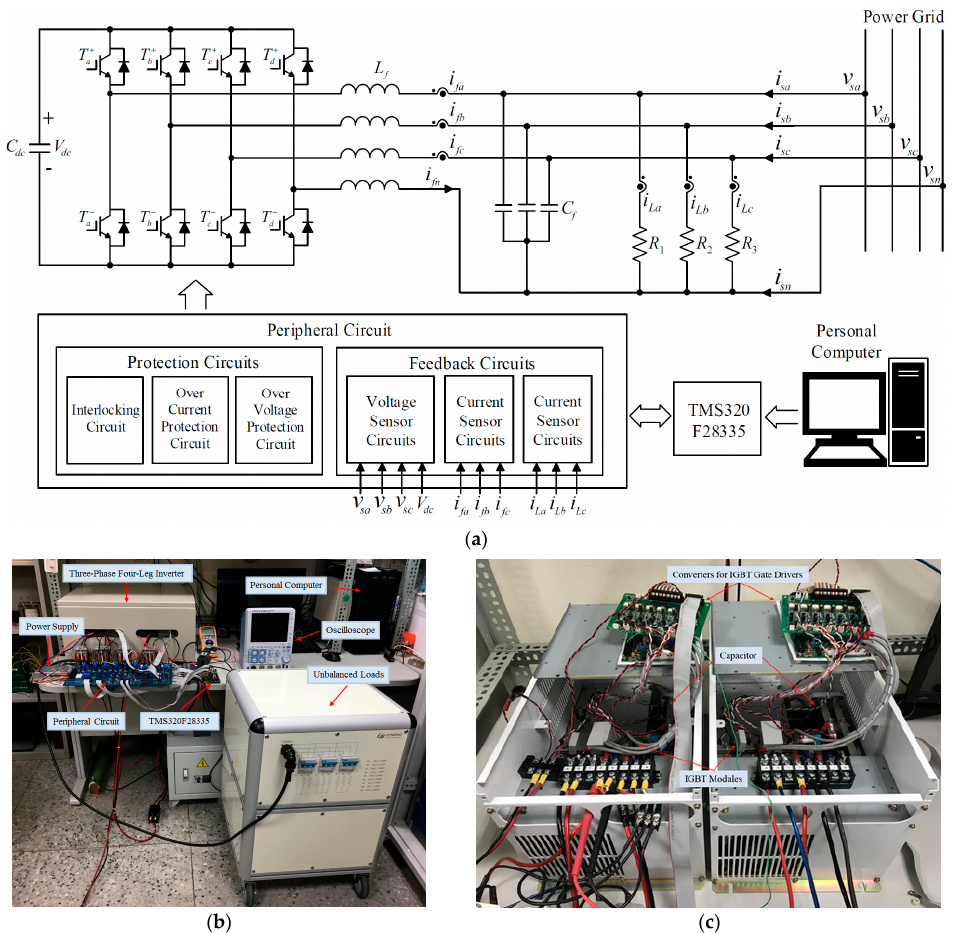
Figure 4. DSP-based shunt APF: ( a ) Block diagram of three-phase four-leg inverter-based shunt APF; ( b ) Photos of DSP-based control platform, unbalanced loads and inverter; and ( c ) Photo of three-phase four-leg inverter.